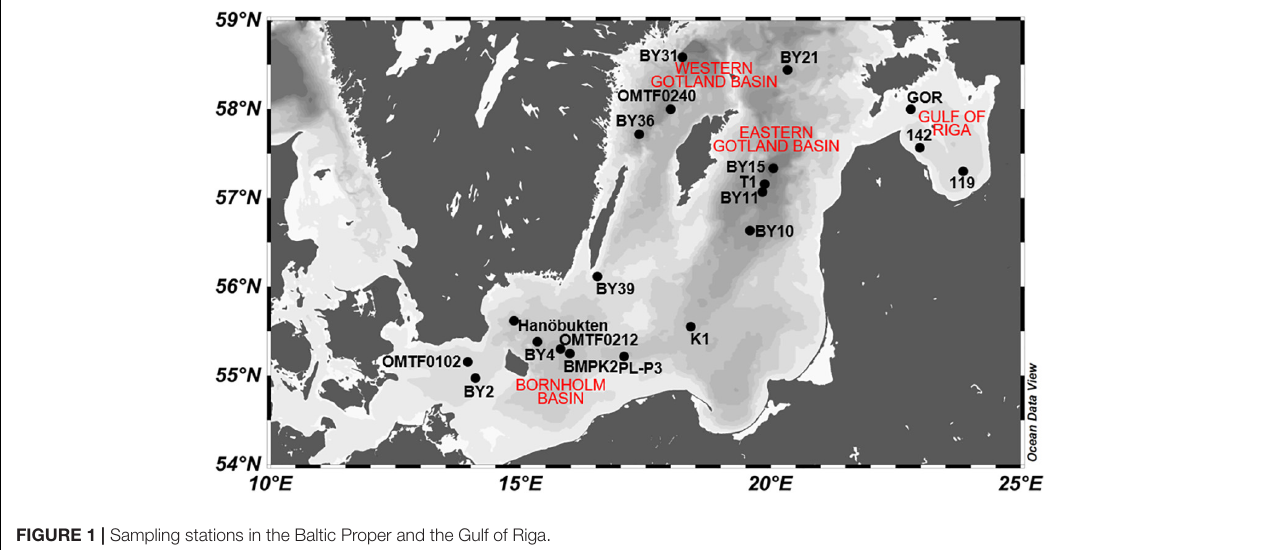
FIGURE 1 | Sampling stations in the Baltic Proper and the Gulf of Riga.